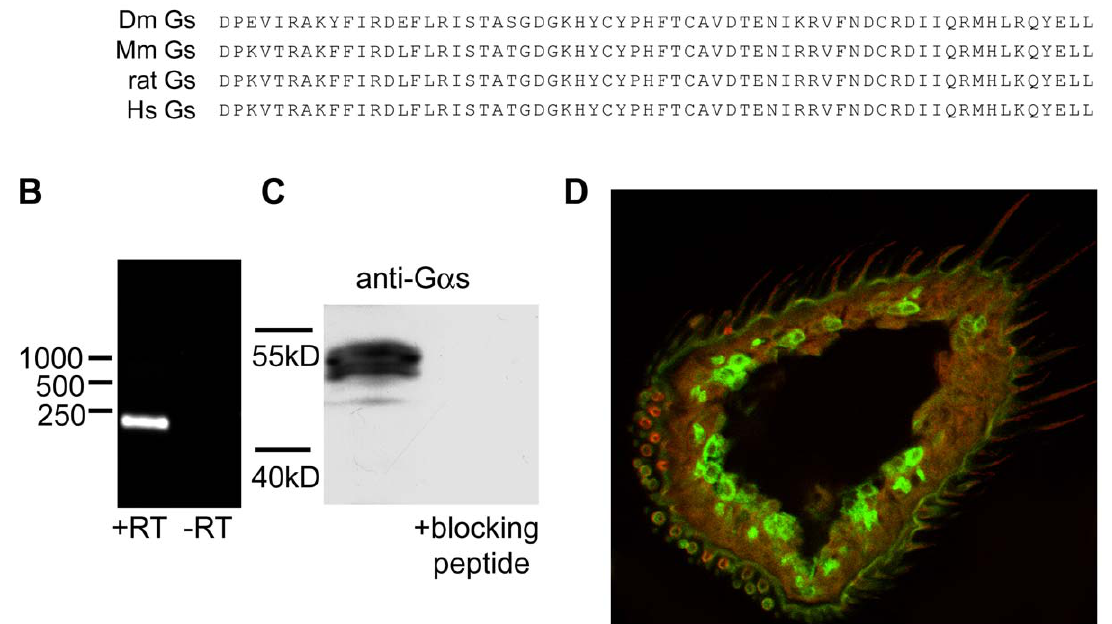
Figure 5. Drosophila G a s is localized in the sensilla of the olfactory sensory neurons. ( A ) Alignment of C-termini of G a s from different species showing the high degree of conservation in this part of the protein. ( B ) RT-PCR with RNA prepared from manually collected antennae using G a s specific primers ( + RT), control lane is RNA without reverse transcription (-RT). ( C ) Western blot of manually collected antennae probed with anti- G a s showing a band approximately 50 kD, which disappears after pre-incubation of the antibody with a specific blocking peptide. ( D ) Staining of the third antennal segment using G a s specific antibodies. Red - G a s ; Green – mCD8-GFP ( Or83b-Gal4; UAS-mCD8-GFP